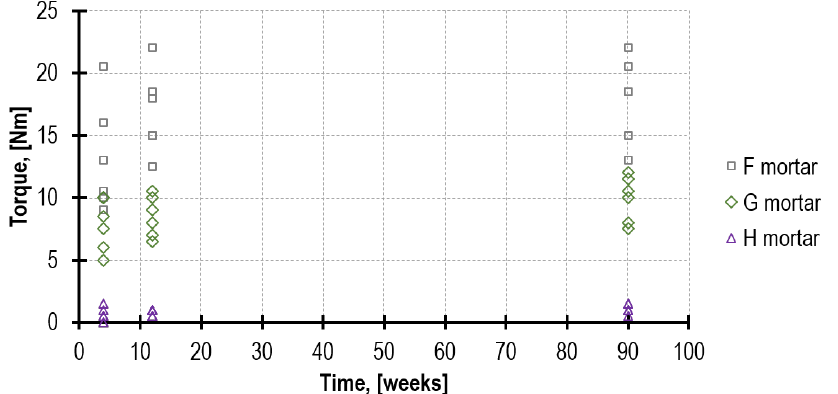
Figure 14. The torque values recorded for mortar F, G and H with the use of 7 mm pilot hole. The H mortar did not allow for the proper anchorage of the penetrating nail. Table 6. Mortar TPT strength f m.TPT in